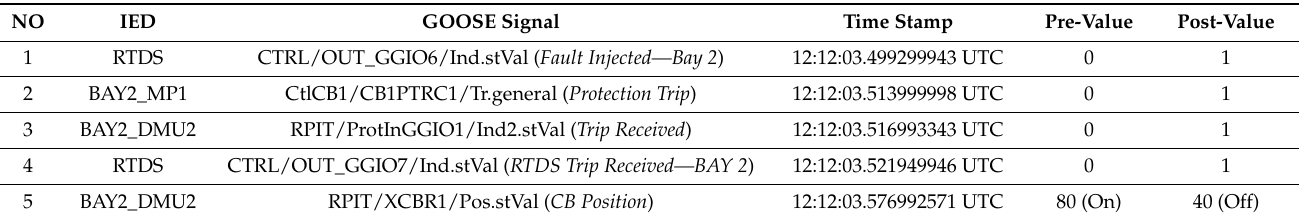
Table 3. Example of GOOSE events recorded by the visualisation tool.